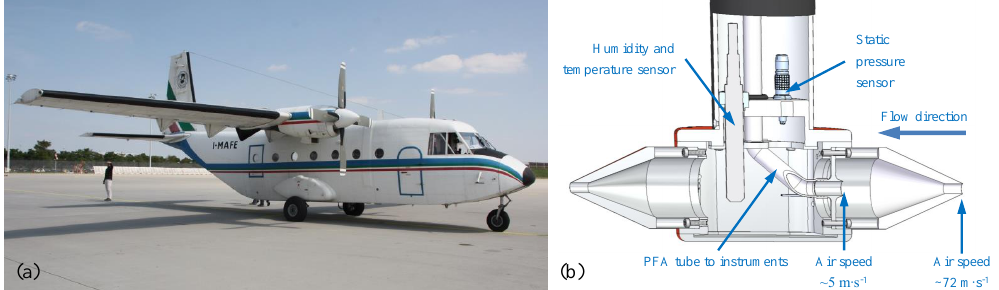
Figure 1. For the ETMEP-2 campaign in August 2013 the CASA 212 (a) from the Italian company, Compagnia Generale Ripreseaeree (http://www.terraitaly.it/), was equipped with specially designed and manufactured trace gas inlet (b) .